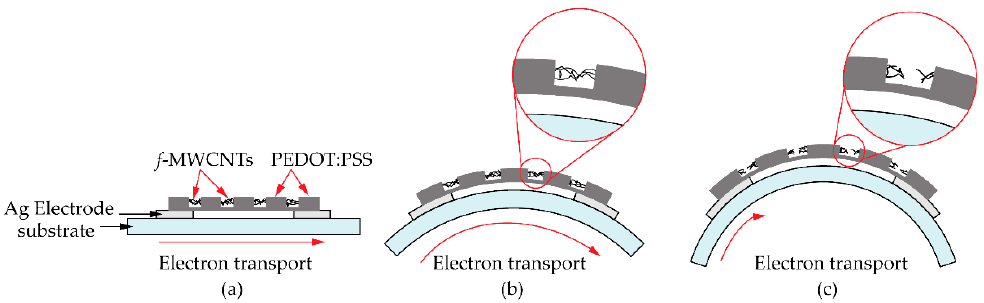
Figure 13. Schematic diagram of pathways in electron transports for f -MWCNT-PEDOT:PSS gas sensor (S3 sample) under ( a ) flat state, ( b ) 3.0 cm and ( c ) 0.9 cm bending-radius state.